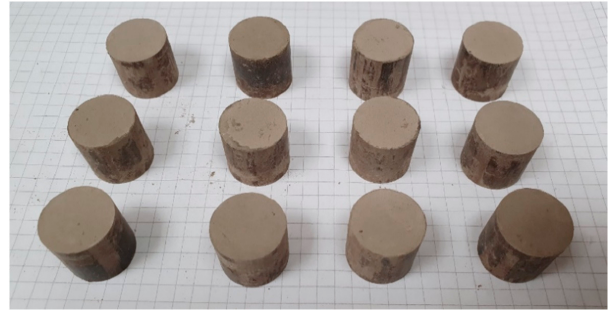
Figure 1. 100% APP-EPA compacted